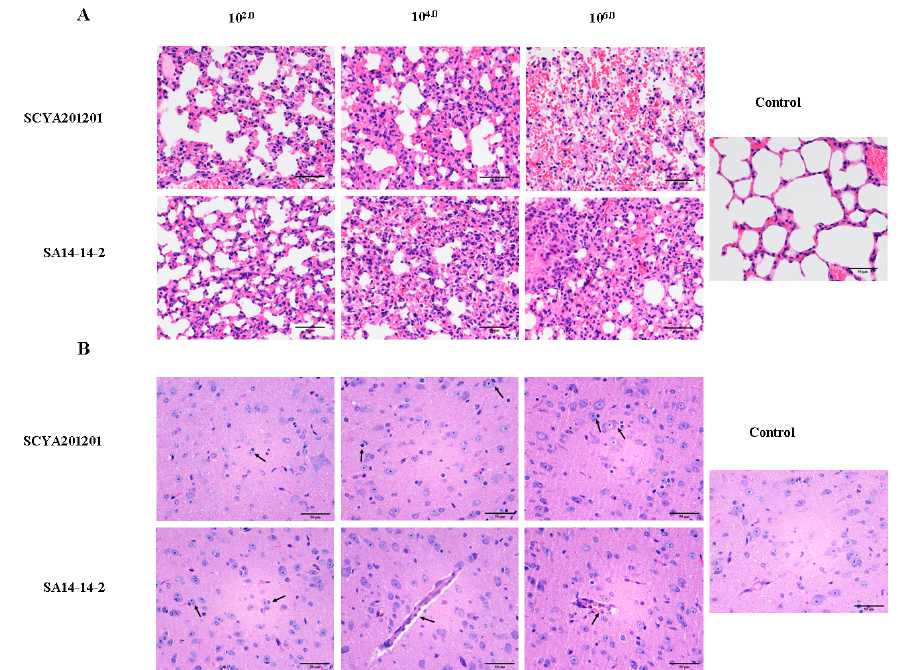
Figure 3. Hematoxylin and eosin (H+E) analysis of mouse lung and brain sections. Four-week-old mice were i.n. inoculated with different doses (10 2 , 10 4 , or 10 6 pfu/50 μ L) of the SCYA201201 or SA14-14-2 virus. ( A ) H+E staining of mouse lung sections revealed pathologic changes consistent with JEV infection. The scale indicates 50 μ m. ( B ) The H+E staining of mouse brain sections revealed brain lesions consistent with JEV infection. The brain lesions are indicated by arrows. There are no microscopic lesions in the lung and brain of the control mice. The scale indicates 50 μ m.